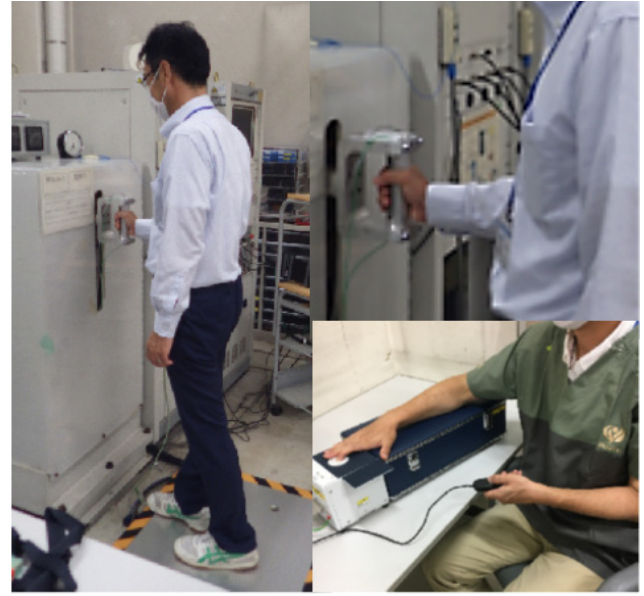
Figure 2. Subject’s posture condition in the grip task with exposure to HAV and at the measurement of vibrotactile perception.